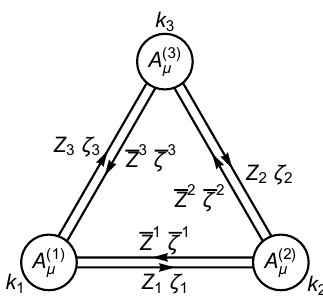
Figure 1. The quiver diagram of a toy model N = 2 SCSM